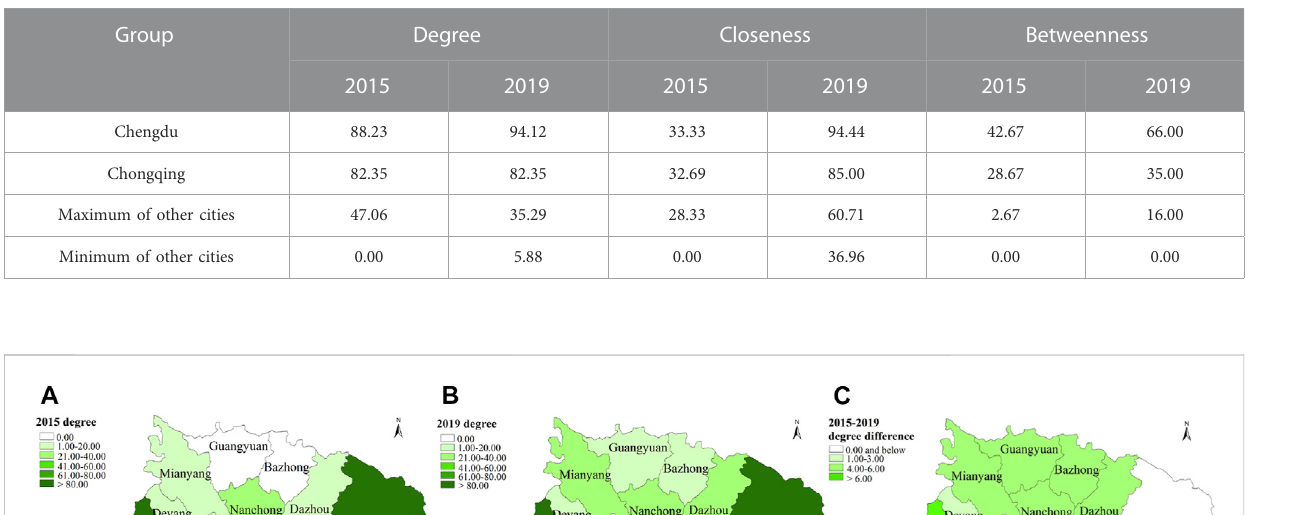
TABLE 1 Typical degree, closeness and betweenness of different cities in PM 2.5 association in SCB.